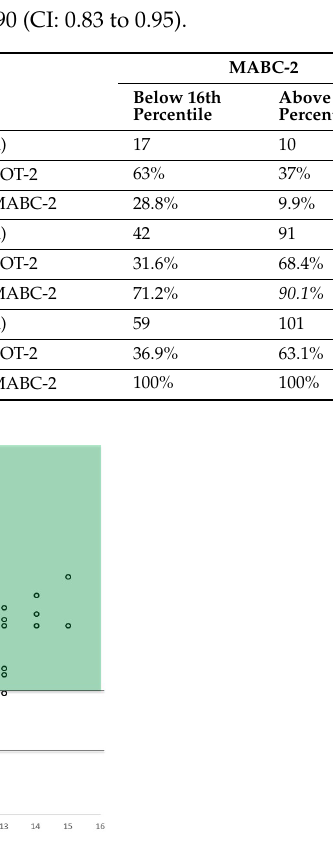
Table 6. Sensitivity and specificity of MABC-2 and BOT-2 for 160 children with complete results.